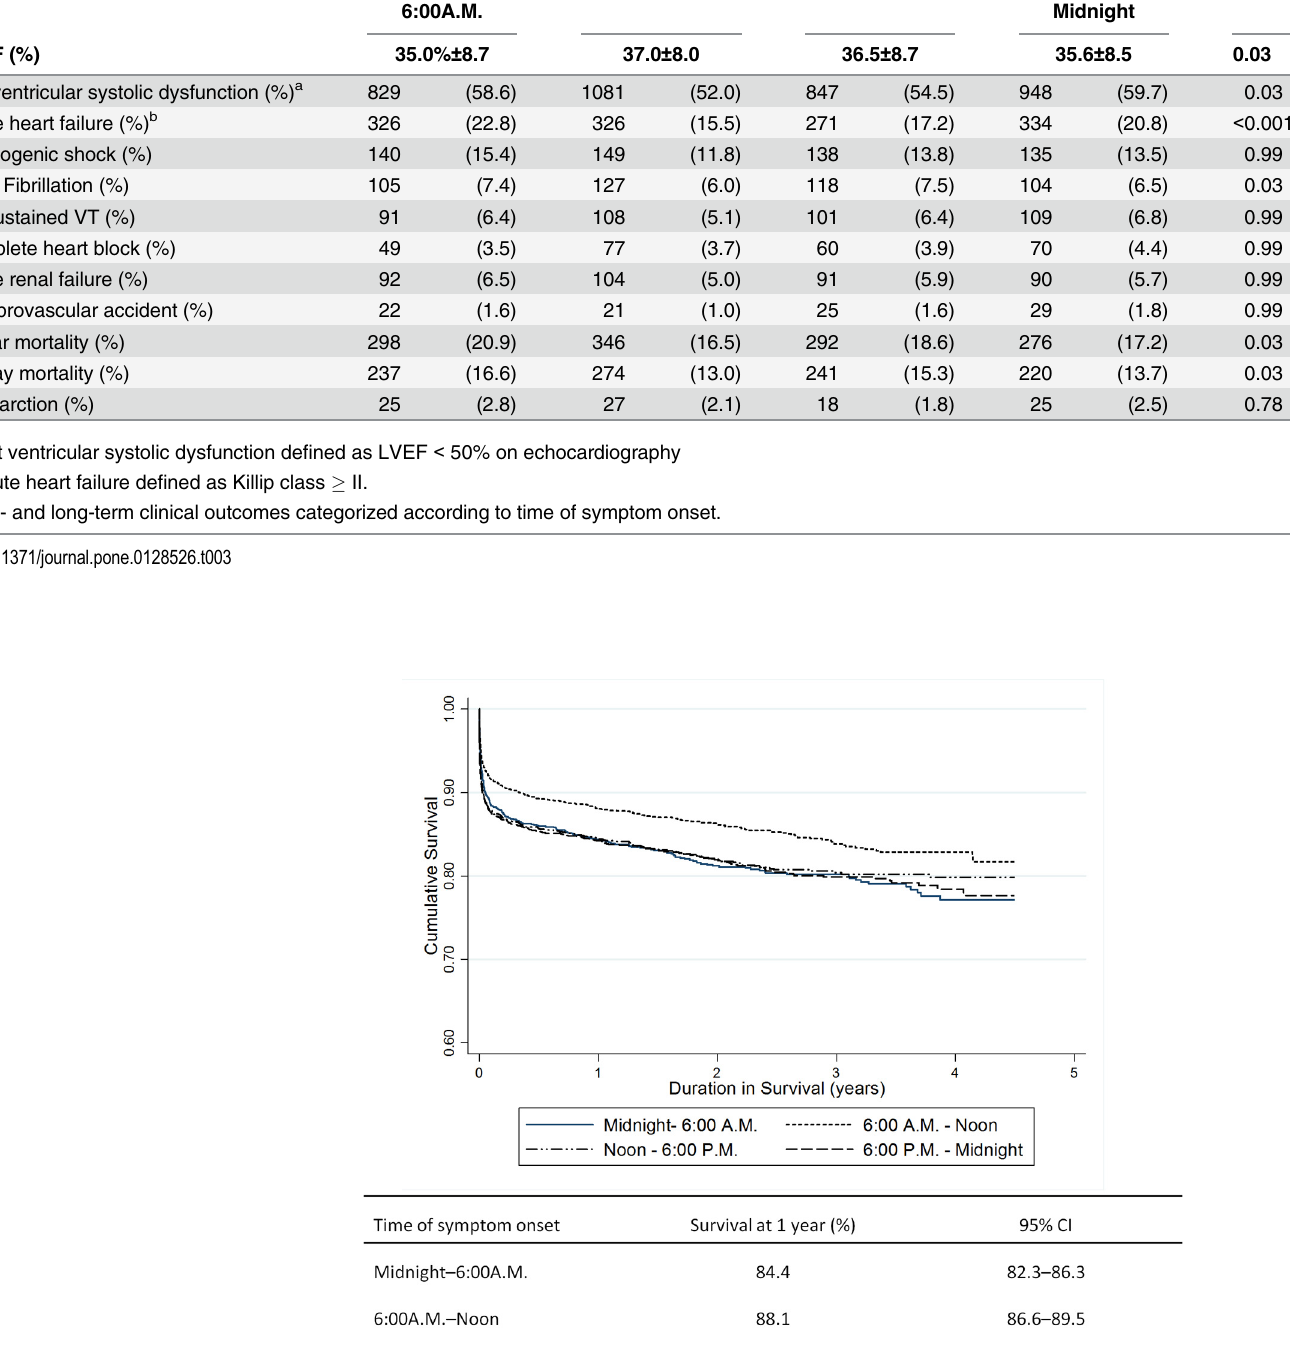
Table 3. Complications of AMI and clinical outcomes.